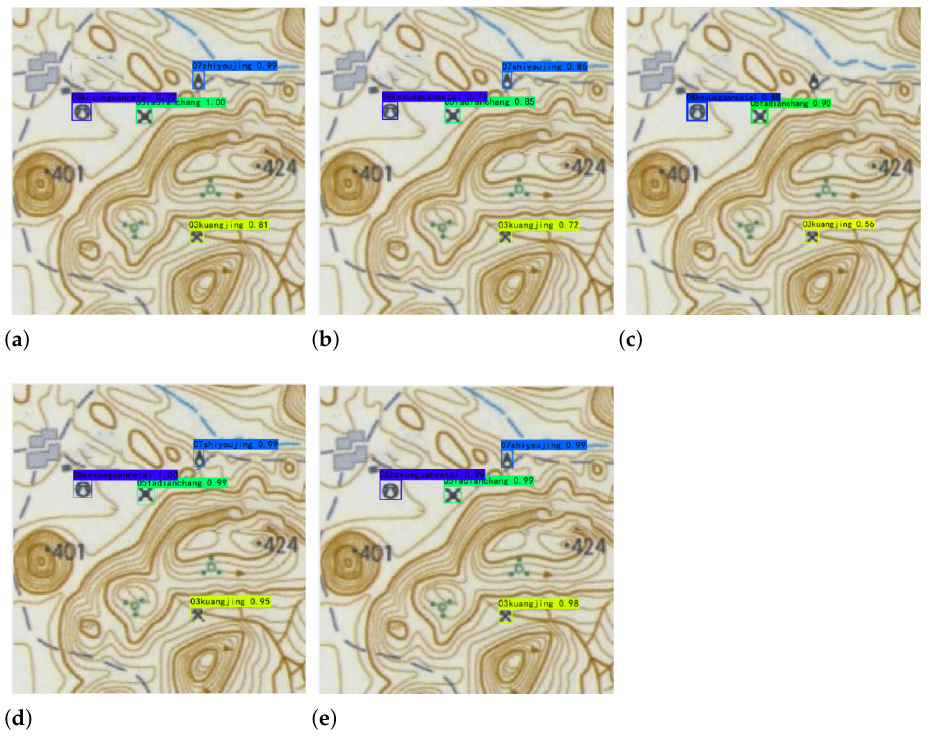
Figure 13. Results obtained by different models for Map A: ( a ) faster R-CNN, ( b ) VGG-SSD, ( c ) YOLOv3, ( d ) YOLOv4, and ( e )